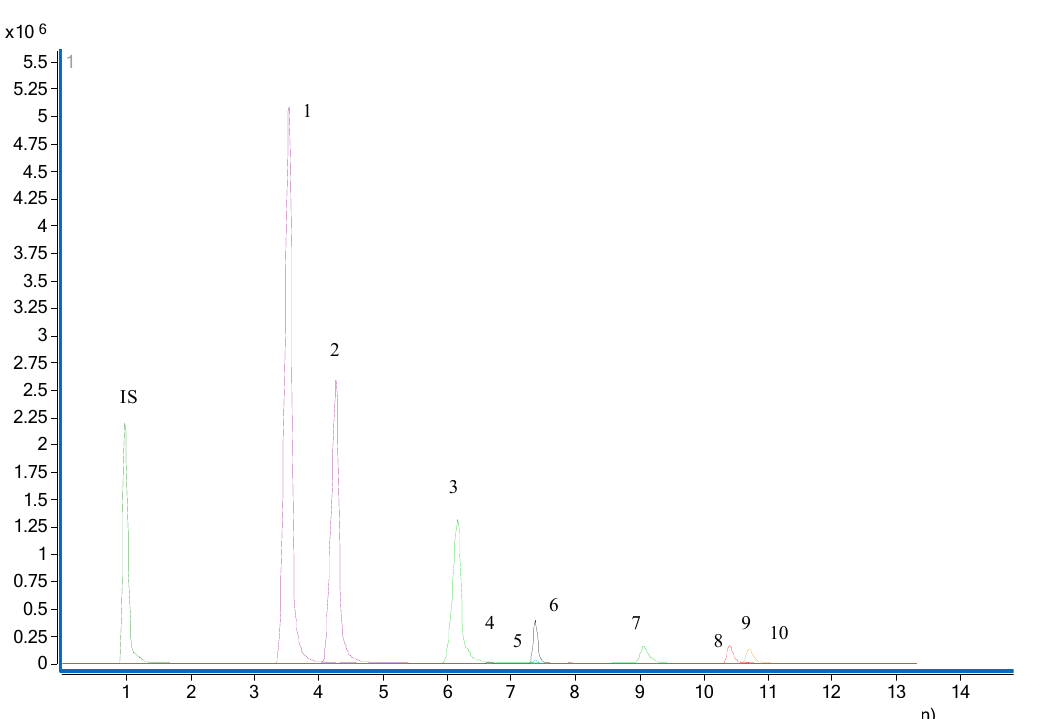
Figure 1. MRM chromatogram of the 10 neurotransmitters. 1, butyrylcholine; 2, acetylcholine; 3, choline; 4, taurine; 5, homovanillic acid; 6, tyrosine; 7, noradrenaline; 8, serine; 9, aspartic acid; 10, asparagine.